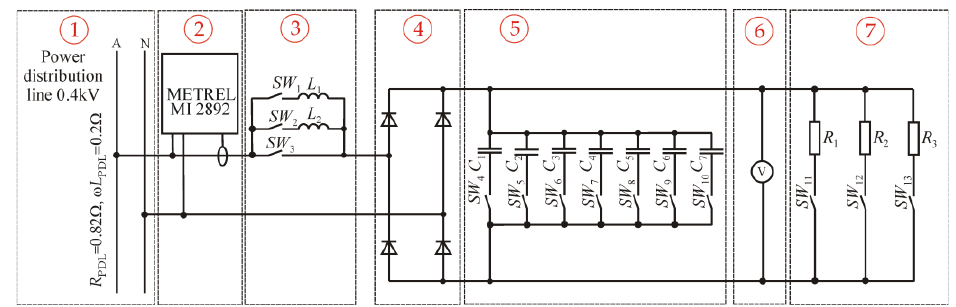
Figure 7. Circuit diagram of experimental setup for the reactive power provided or drawn out by diode rectifier supply-side device analysis. diode rectifier supply-side device